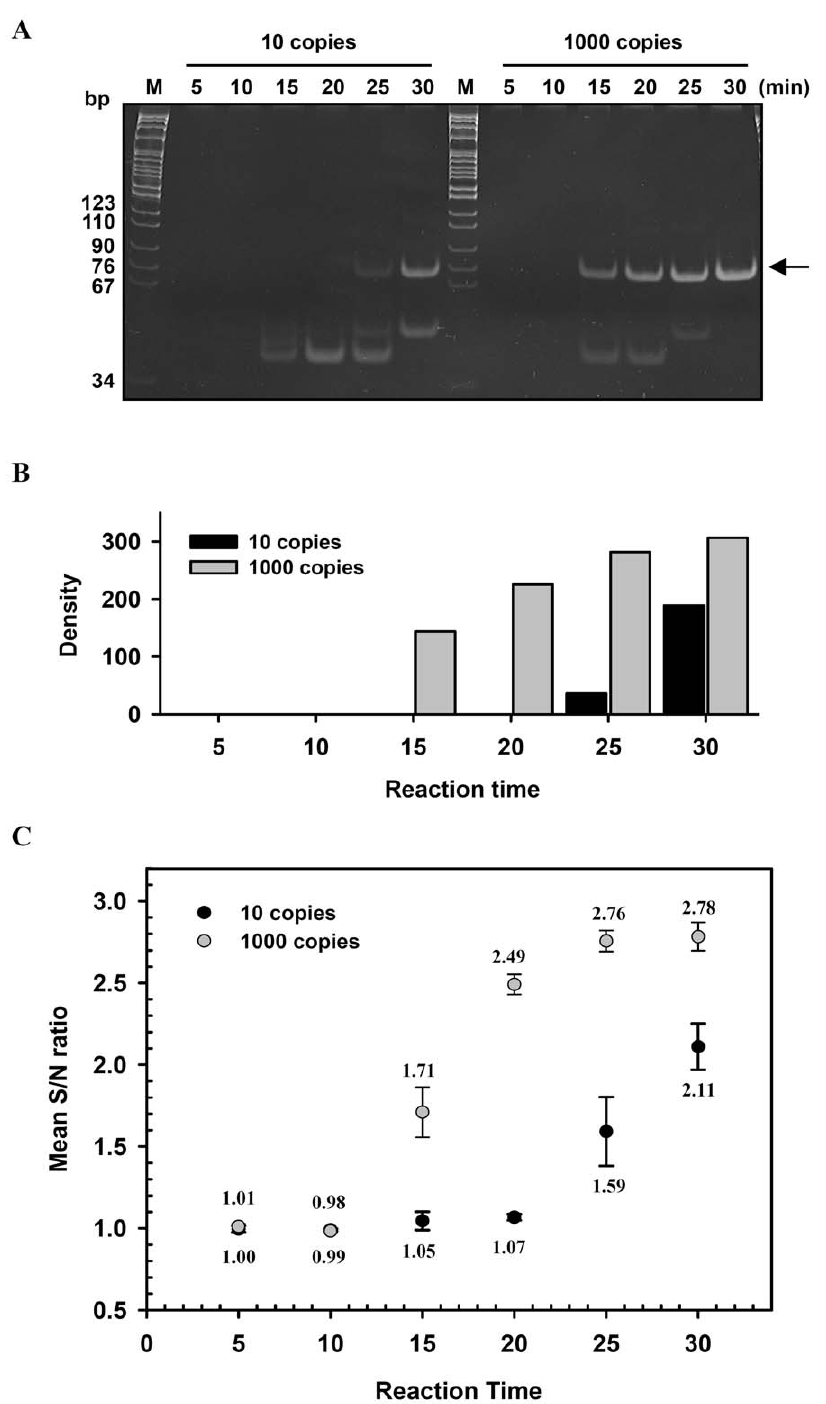
Figure 4. Time course of WSSV TaqMan probe-iiPCR. WSSV TaqMan probe-iiPCR reactions containing 10 1 and 10 3 copies of pWSSV1 were allowed to be carried out for 5, 10, 15, 20, 25, or 30 min. Amplicons were detected by 12% polyacrylamide gel analysis (A), and the intensity of the bands was estimated by densitometry (ImageJ program, NCBI) (B). In addition, fluorescent signals of three independent experiments were collected, and S/N ratios and SDs were calculated (C). Arrows, iiPCR amplicons; M, DNA size markers; S/N ratio, fluorescent intensity after /fluorescent intensity before . doi:10.1371/journal.pone.0045278.g004 and 1.60, Supplementary Table 2, samples 19 and 34) were interval: 88.5% to 99.6%) (Table 2). The results show 96.67% generated in TaqMan probe-iiPCR from two of the 60 WSSV- agreement (Kappa test) between the two assays. Over all, results of negative samples, resulting in 96.7% specificity (95% confidence WSSV TaqMan probe-iiPCR correlated well with those of